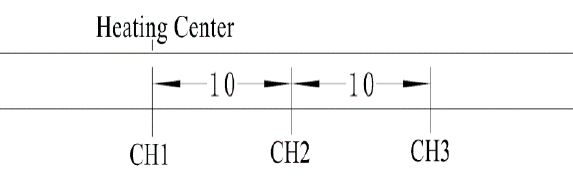
Figure 1. Schematic of temperature field measurement (mm).